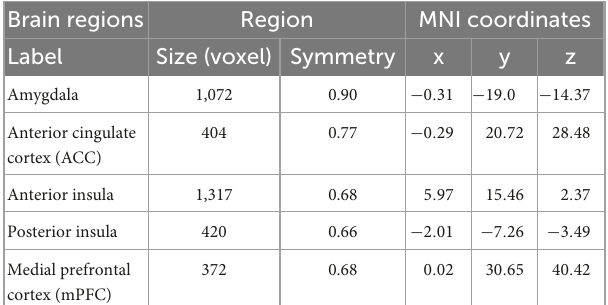
TABLE 1 Details of the regions of interest (ROIs) most implicated in the neural processing of emotion regulation in peer-victimized adolescents. Brain regions Region MNI